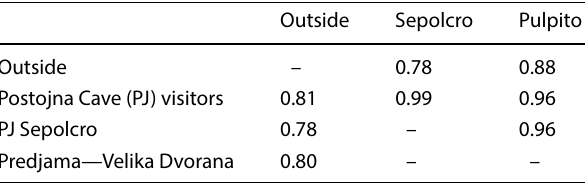
Table 3 Pearson correlation coefficients (PCCs) for Postojnska Jama (1934 –2019) and Predjama Cave (1942–2019) calculated on the basis of mean annual air temperature values and annual visitor